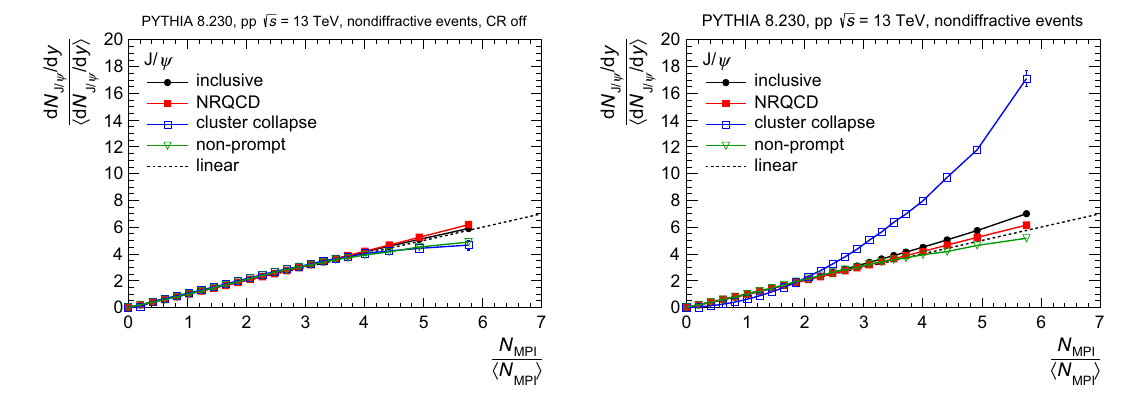
Fig. 5 Self-normalized J /ψ yield from non-diffractive events, generated with PYTHIA8, split in different production processes as a function of the number of multiparton interactions. Left: colour reconnection switched off, right: colour reconnections on